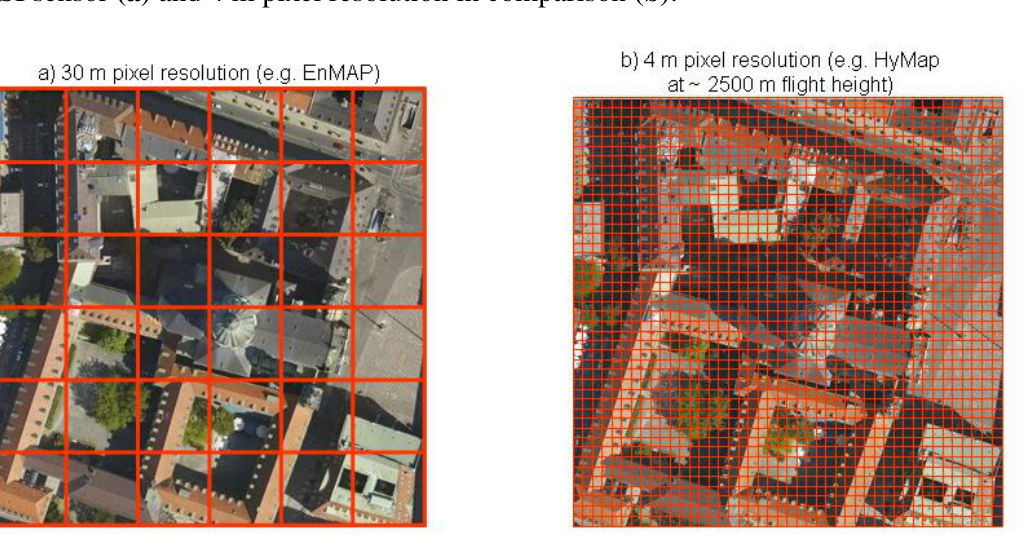
Figure 1. Spectral mixed pixels: simulated 30 m pixel resolution like planned for EnMAP HSI sensor (a) and 4 m pixel resolution in comparison (b)